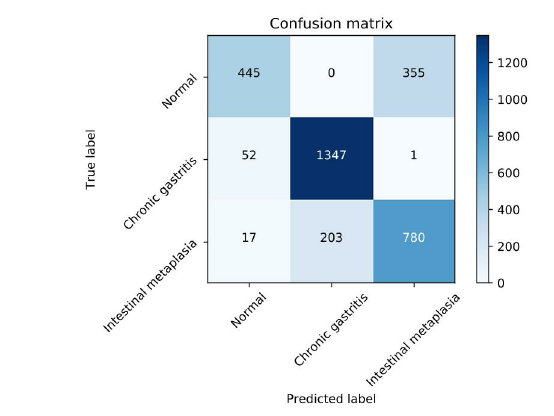
Figure 5. Confusion matrix.